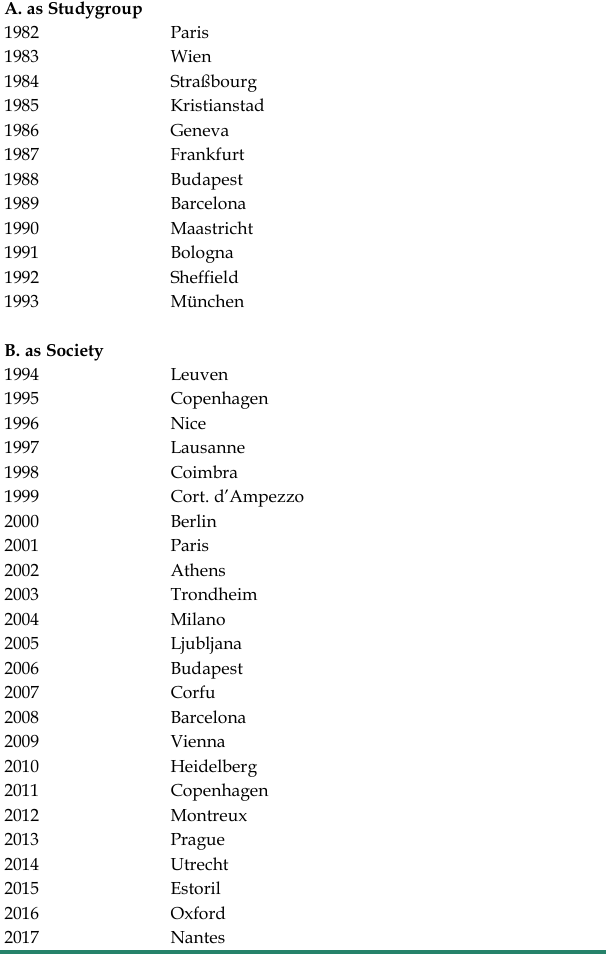
Table 3 . Annual meetings of the Study Group and